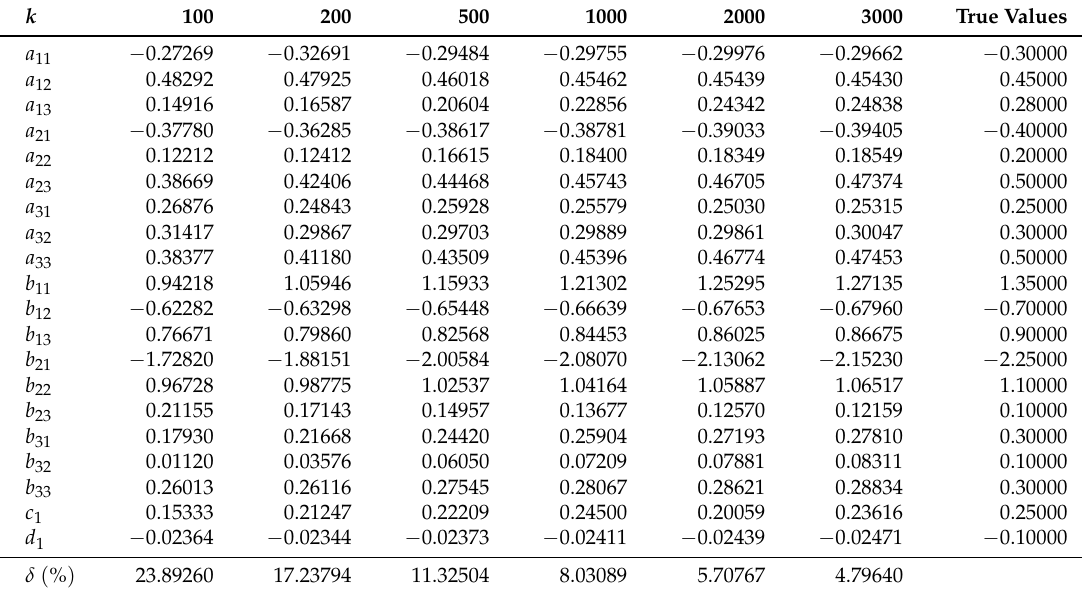
Table 2. The F-M-ML-MIESG estimates and errors ( σ 2 = 0.10 2 , p =